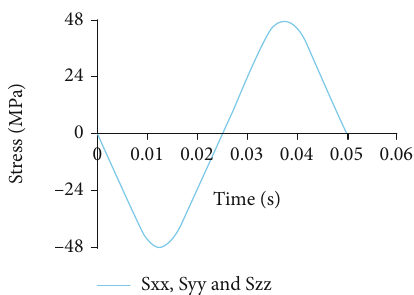
Figure 5: Dynamic stress